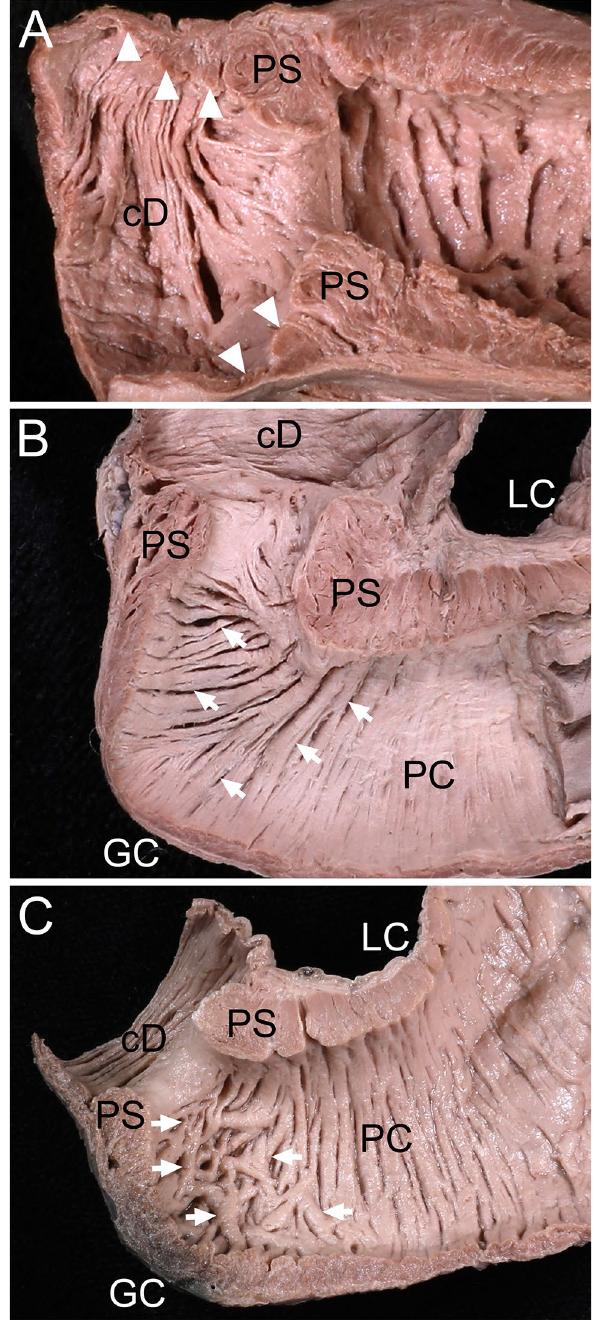
Figure 4. Arrangement of muscle bundles between the pyloric sphincter (PS), duodenum, and the pyloric canal (PC). ( A ) The circular bundles of the duodenum (cD) (arrowheads) adjacent to the PS were the thickest, and gradually reduced in thickness between the PS and duodenum in a longitudinal section between the lesser curvature (LC) and greater curvature (GC). ( B ) The circular bundles (arrows) of the PS on the LC side spread out to connect to the circular bundles of the aboral end of the PC on the GC side. ( C ) The circular bundles (arrows) of the aboral end of the PC adjacent to the PS were irregularly arranged. The PS was cut along a longitudinal section through the PS wall including the LC and